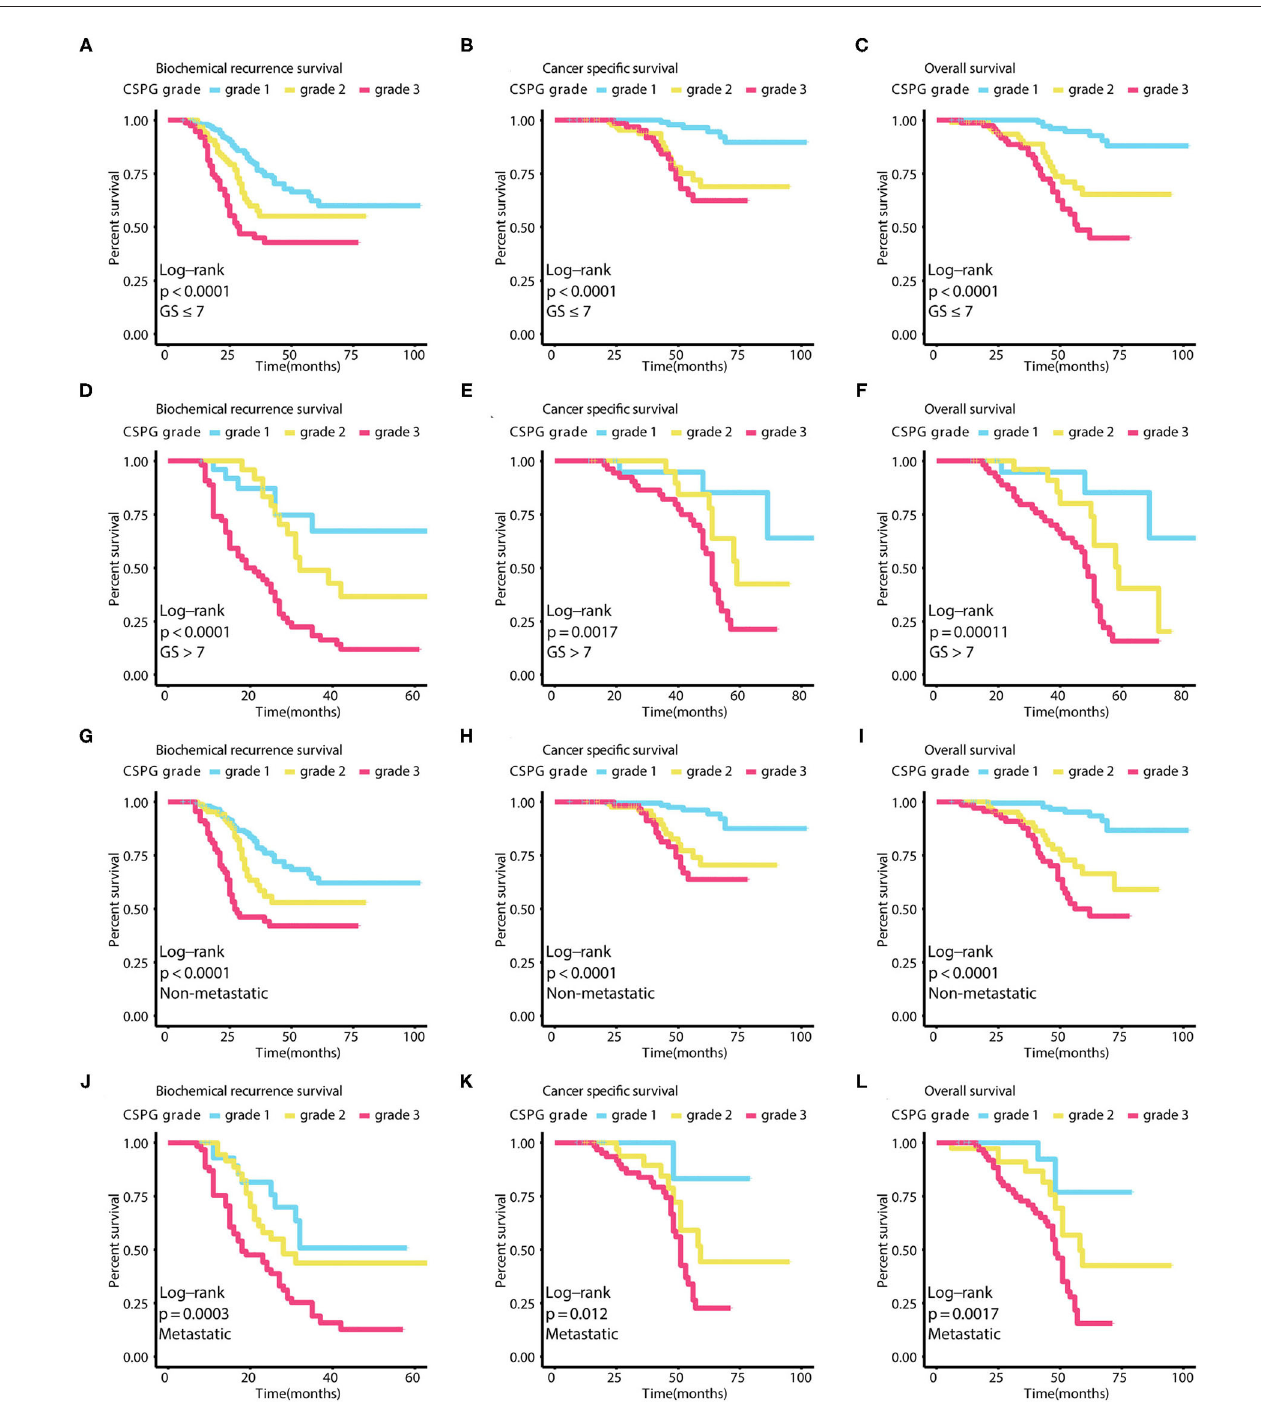
FIGURE 4 | Survival curves in different subgroups of combined cysteine rich secretory protein 3 (CRISP3) and serine peptidase inhibitor Kazal type 1 (SPINK1) prognostic grade (CSPG) based on different survival events. These curves reveal that BCR worsens with increased CSPG grade in patients whose Gleason score ≤ 7 [ (A) , log-rank test P < 0.0001], in patients whose Gleason score > 7 [ (D) , log-rank test P < 0.0001], in patients without metastasis [ (G) , log-rank test P < 0.0001], and in patients with metastasis [ (J) , log-rank test P = 0.0003]. These curves reveal that CSS worsens with increased CSPG grade in patients whose Gleason score ≤ 7 [ (B) , log-rank test P < 0.0001], in patients whose Gleason score > 7 [ (E) , log-rank test P = 0.0017], in patients without metastasis [ (H) , log-rank test P < 0.0001], and in patients with metastasis [ (K) , log-rank test P = 0.012]. These curves reveal that OS worsens with increased CSPG grade in patients whose Gleason score ≤